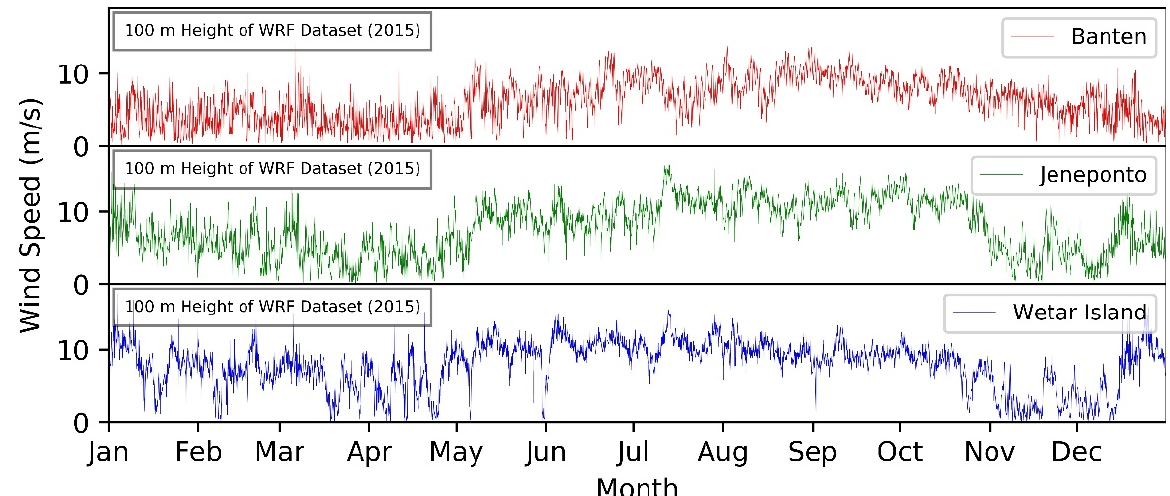
Figure 5. WRF wind speed at 100 m for offshore sites in 2015. Table 2. Weibull fit distribution parameters for the studied sites (2015).